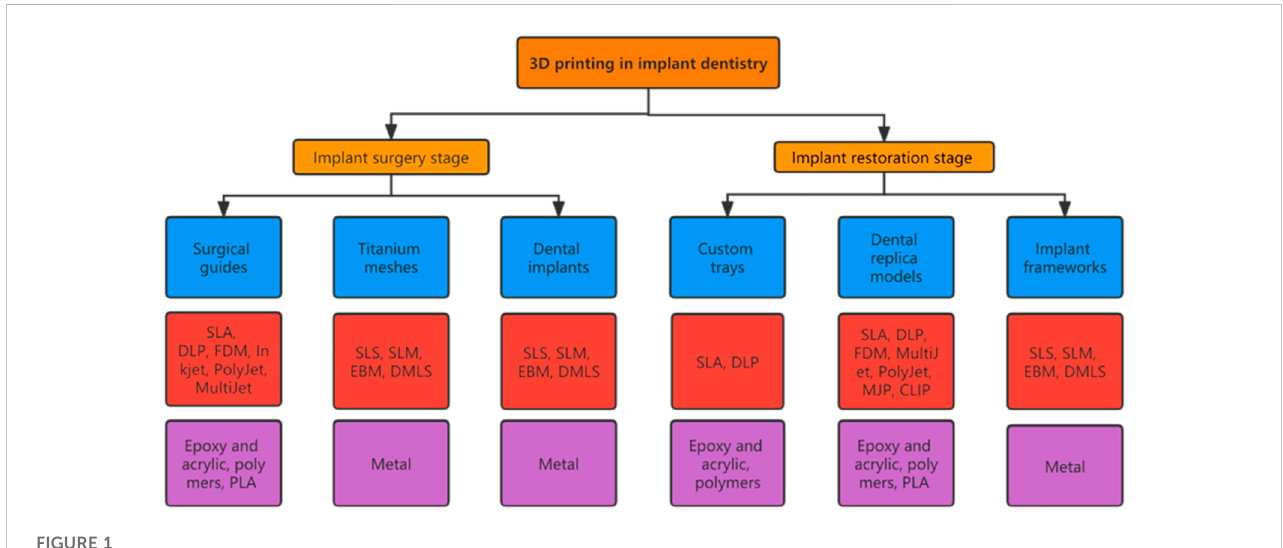
FIGURE 1 Applications of 3D printing technologies commonly used in implant dentistry. Chart showing the applications (blue boxes), primary 3D printing technologies (red boxes), and materials needed (purple boxes) (Dawood et al., 2015; Khorsandi et al., 2021; Tian et al.,